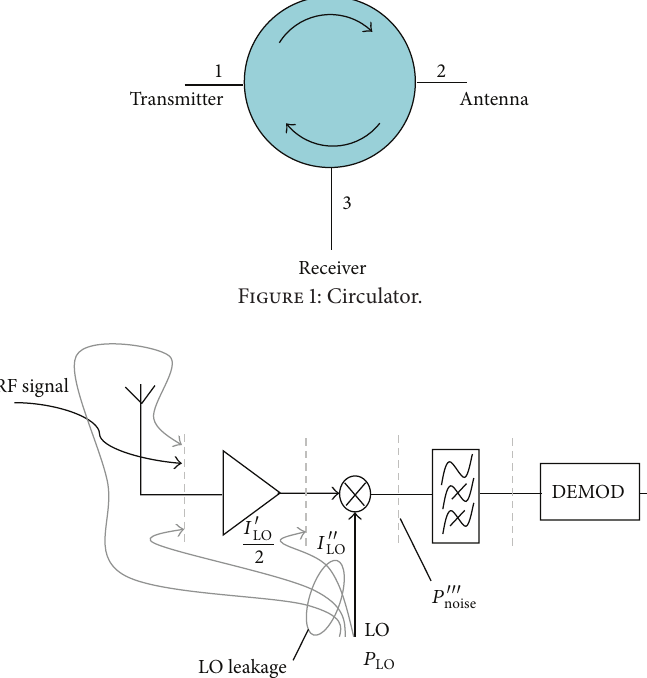
Figure 2: Paths of carrier